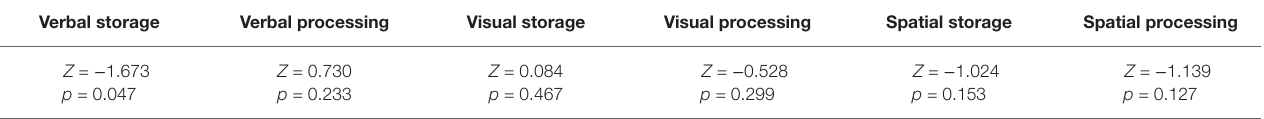
TABLE 5 | Comparison of correlations ( r ’s) between school maths grades and cognitive measures in each of the two schools. Verbal storage Verbal processing Visual storage Visual processing Spatial storage Spatial processing